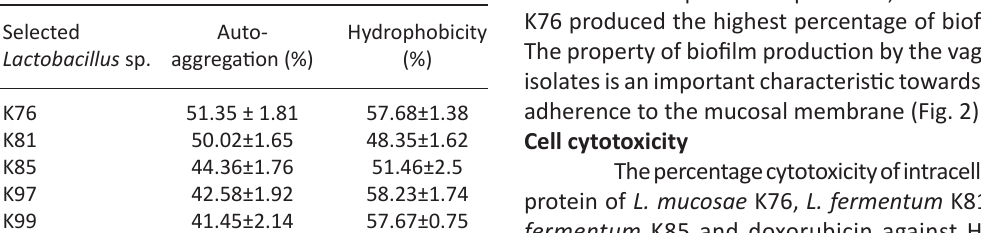
Table 2. Percentage of auto-aggregation and cell- surface hydrophobicity of the Lactobacillus mucosae (K76), L. fermentum (K81), L. fermentum (K85), L. reuteri (K97) and L.reuteri K99). Error bars indicate ± standard deviation Selected